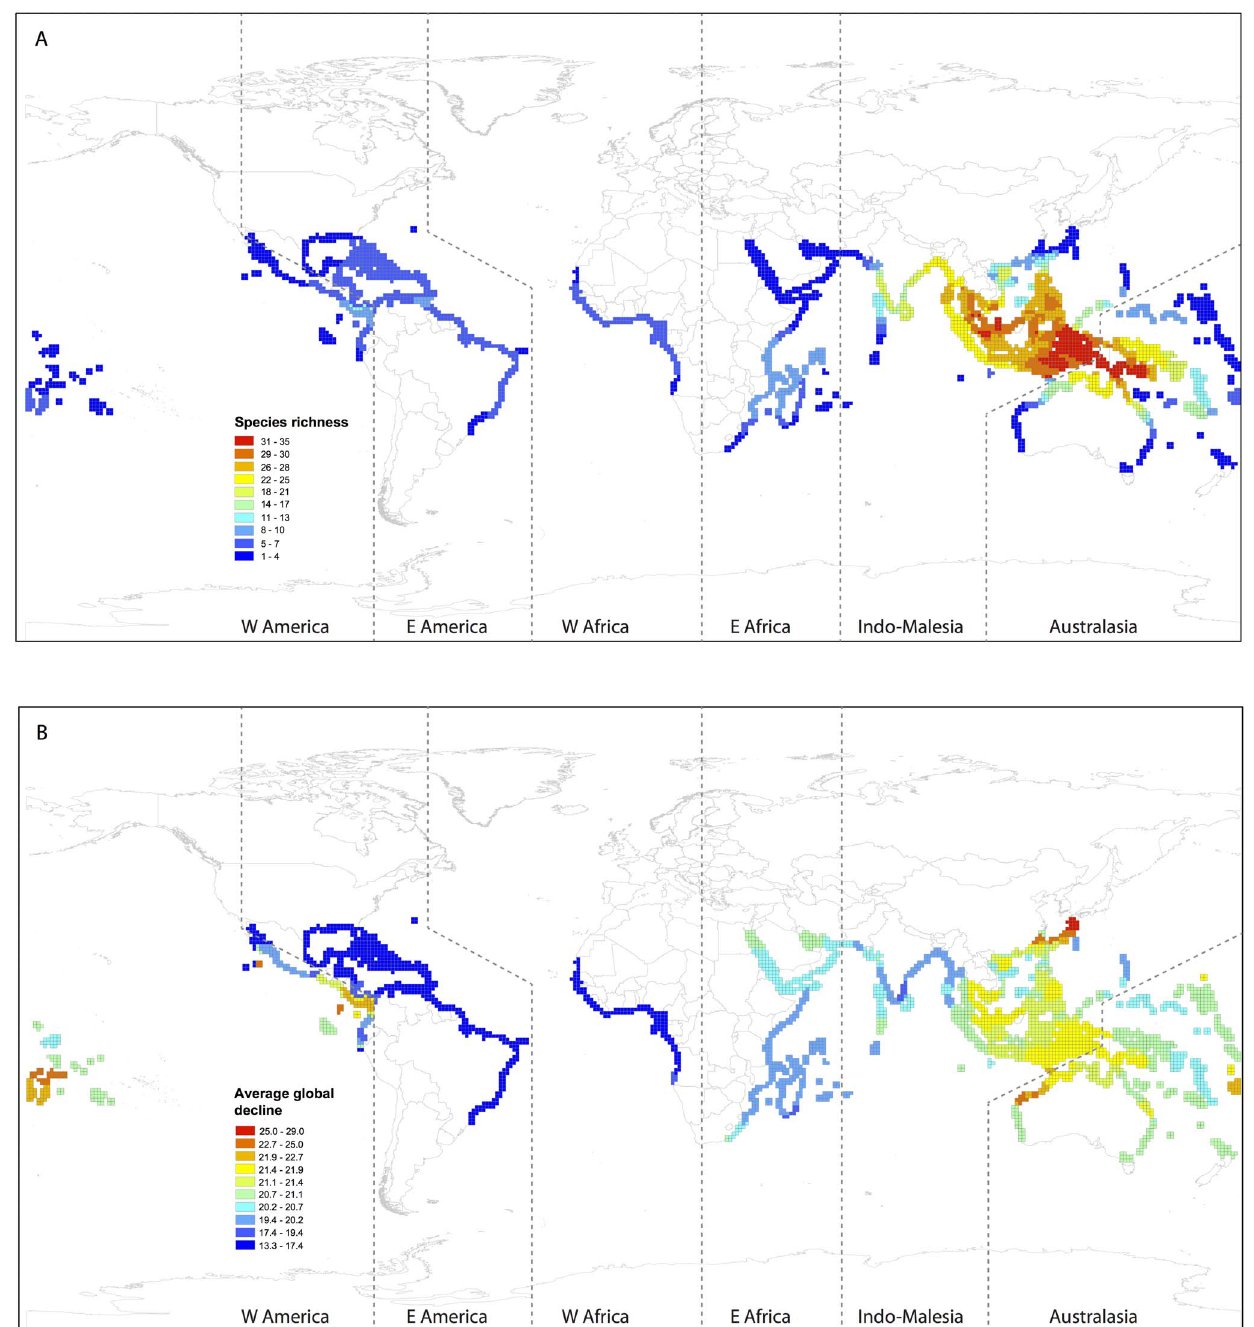
Figure 1. Geographical distribution of species richness (A) and global decline (see Materials and Methods) (B) in mangrove ecosystems across six biogeographical regions, per quarter degree squares (QDS). doi:10.1371/journal.pone.0066686.g001 species assemblages are not simply explained by diversification in the presence of strong geographical barriers and/or environmental filtering. Random patterns may arise from competing processes offsetting one another, for example, environmental attraction versus competitive repulsion (see [51]), and/or frequent dispersal between biogeographic regions. Our observation for phylogenetic over-dispersion in Eastern Africa might also be a product of complex interacting forces, including facilitation [52], competition